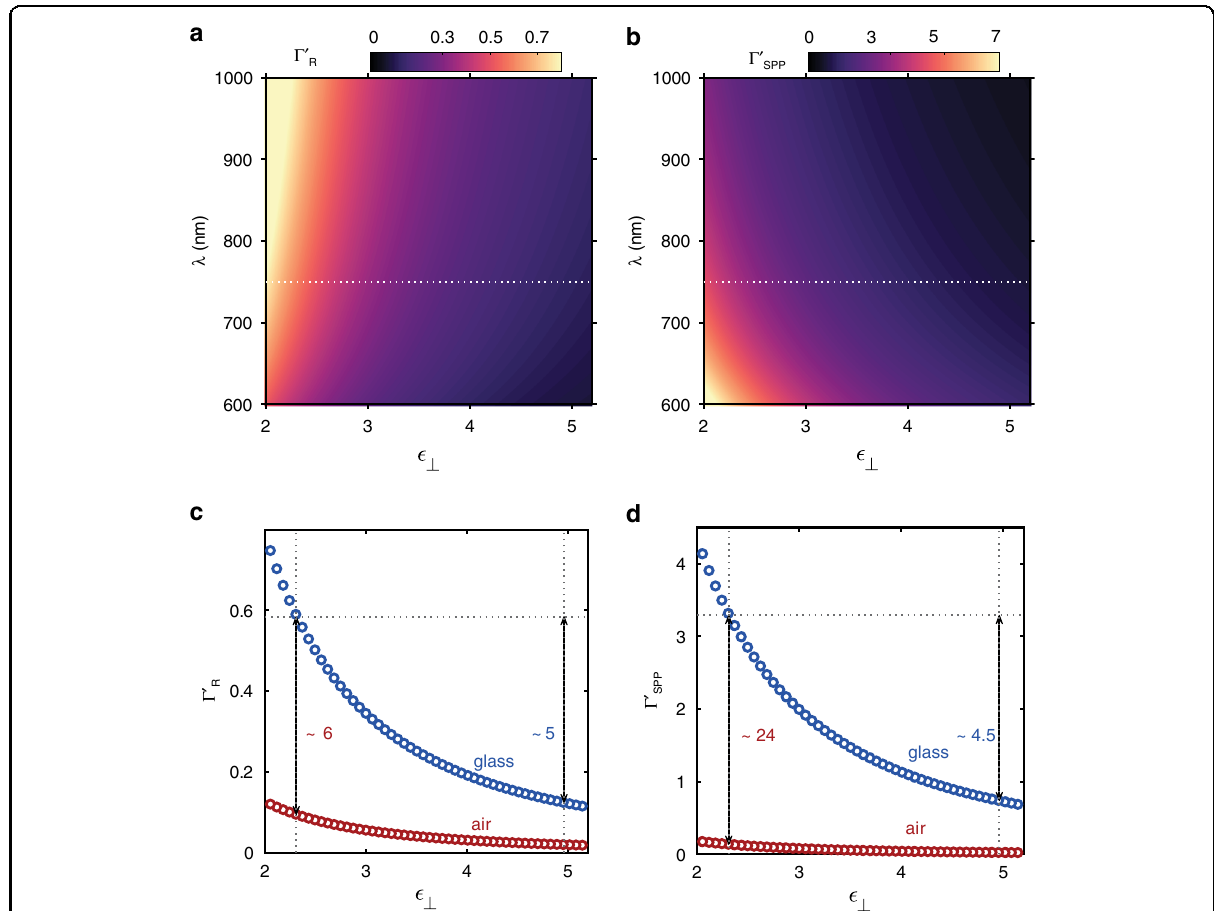
Fig. 3 Decay rate for a general uniaxial medium. a , b Γ ′ Γ ′ and Γ ′ evaluated along the horizontal-dotted lines in ( a , b ) corresponding to λ = 750 nm (blue circles). Red circles represent the data for Γ ′ R SPP Γ ′ evaluated for the TJ geometry with glass replaced by air. Vertical-dotted lines in ( c ) and ( d ) represent ϵ ? ¼ n 2 SPP (right; isotropic case). Right vertical arrows demarcate the enhancement in Γ ′ arrows give the enhancement at ϵ ⊥ = 2.31 with respect to the air